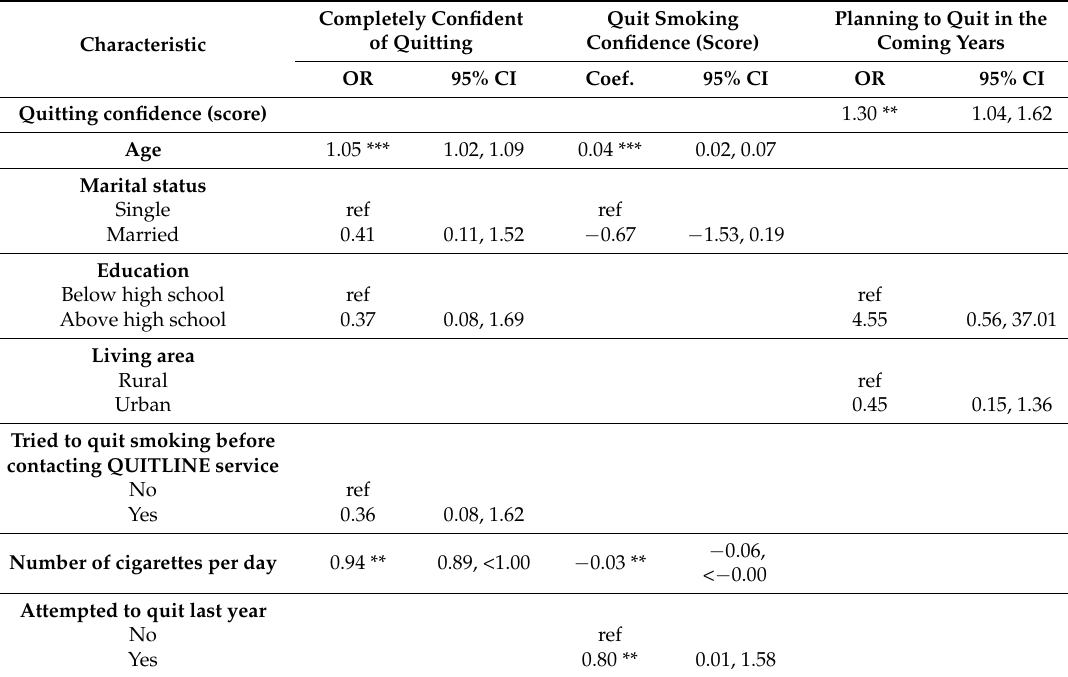
Table 4. Associated factors with quitting attempts and quitting